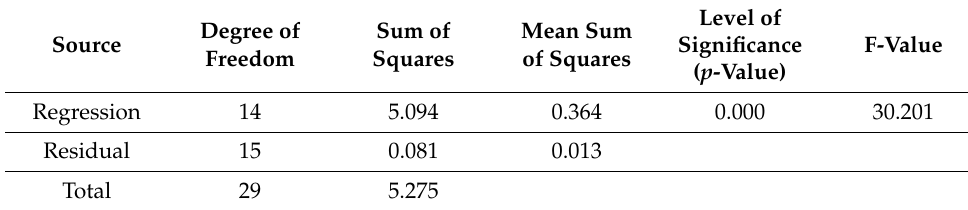
Table 3. Statistical values of ANOVA for optimization of AgNPs using